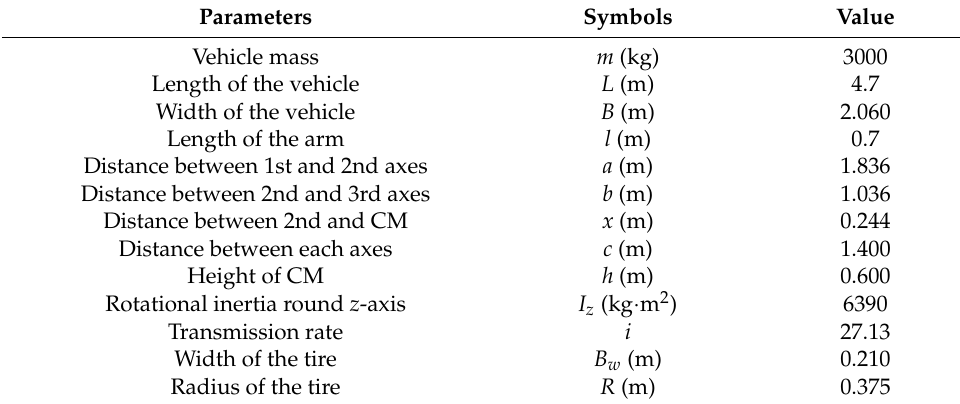
Table 1. Essential parameters of the platform.